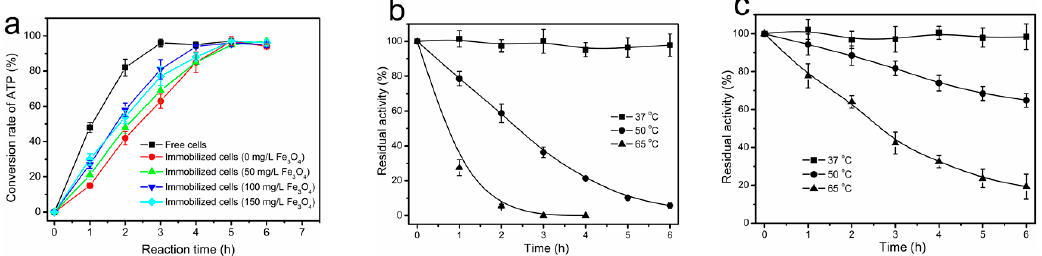
Figure 5. Effect of the concentration of Fe 3 O 4 nanoparticles on the activity of immobilized cells, and the thermal stability of free and magnetically immobilized cells; ( a ) Biosynthesis of SAM by magnetically immobilized cells prepared by the addition of different concentration of Fe 3 O 4 nanoparticles (50–150 mg/L), nonmagnetically immobilized cells, and free cells. The reaction mixtures contained: 40 mM ATP, 50 mM L -methionine, 50 mM K 2 SO 4 , 100 mM MgSO 4 , 0.3 M sodium p -toluenesulfonate, 100 mM Tris-HCl (pH 7.0), and the equivalent amount of biocatalyst for free or immobilized cells, at 37 °C. The conversion rate of ATP was determined by HPLC analysis; ( b,c ) The thermal stability of free and magnetically immobilized cells. Percent enzymatic activity remaining as a function of time for free ( b ); and magnetically immobilized cells ( c ). Assay conditions: 50 mM Tris-HCl buffer, pH 7.5. Initial activities were defined as 100%. The residual activity of free and immobilized cells was measured using the spectrophotometric assay. Enzyme activity was calculated according to the phosphate concentration that was released from the substrate ATP during the reaction.